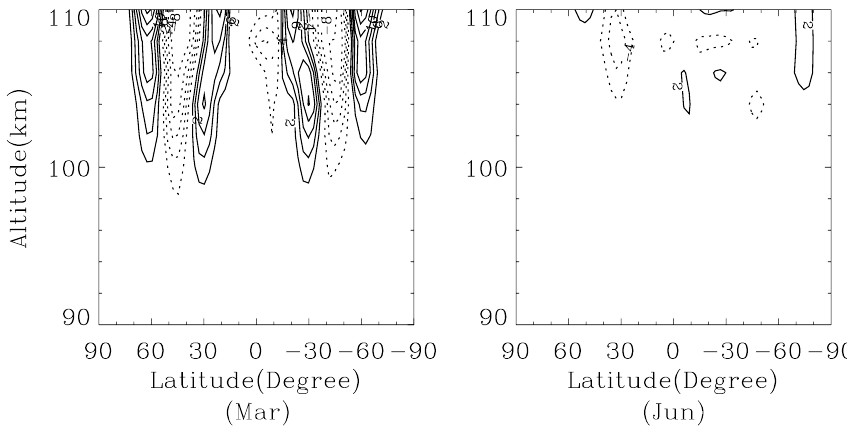
Fig. 4. Temperature amplitude differences after 8 tidal periods for March (left) and June (right) deduced from the nonlinear propagation solutions of the migrating semidiurnal tide starting from GSWM-00 tidal oscillations. The intervals of the contours are 2K. The solid and dotted curves denote the positive and negative values,